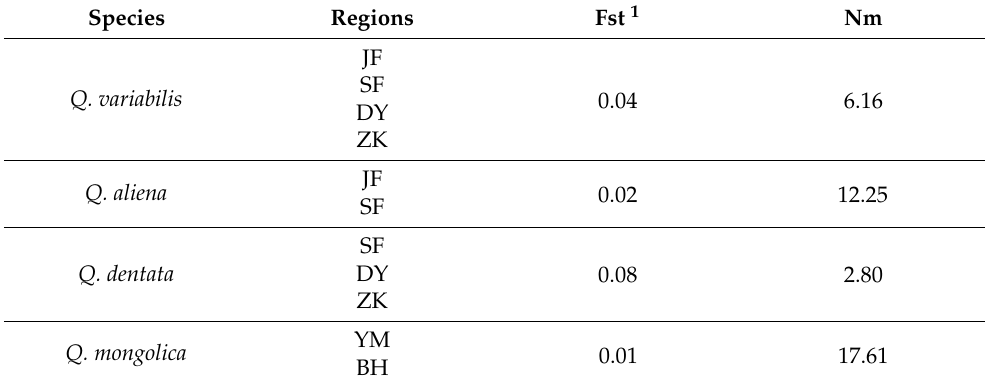
Table 2. Genetic variation among populations within the same oak species in different regions.